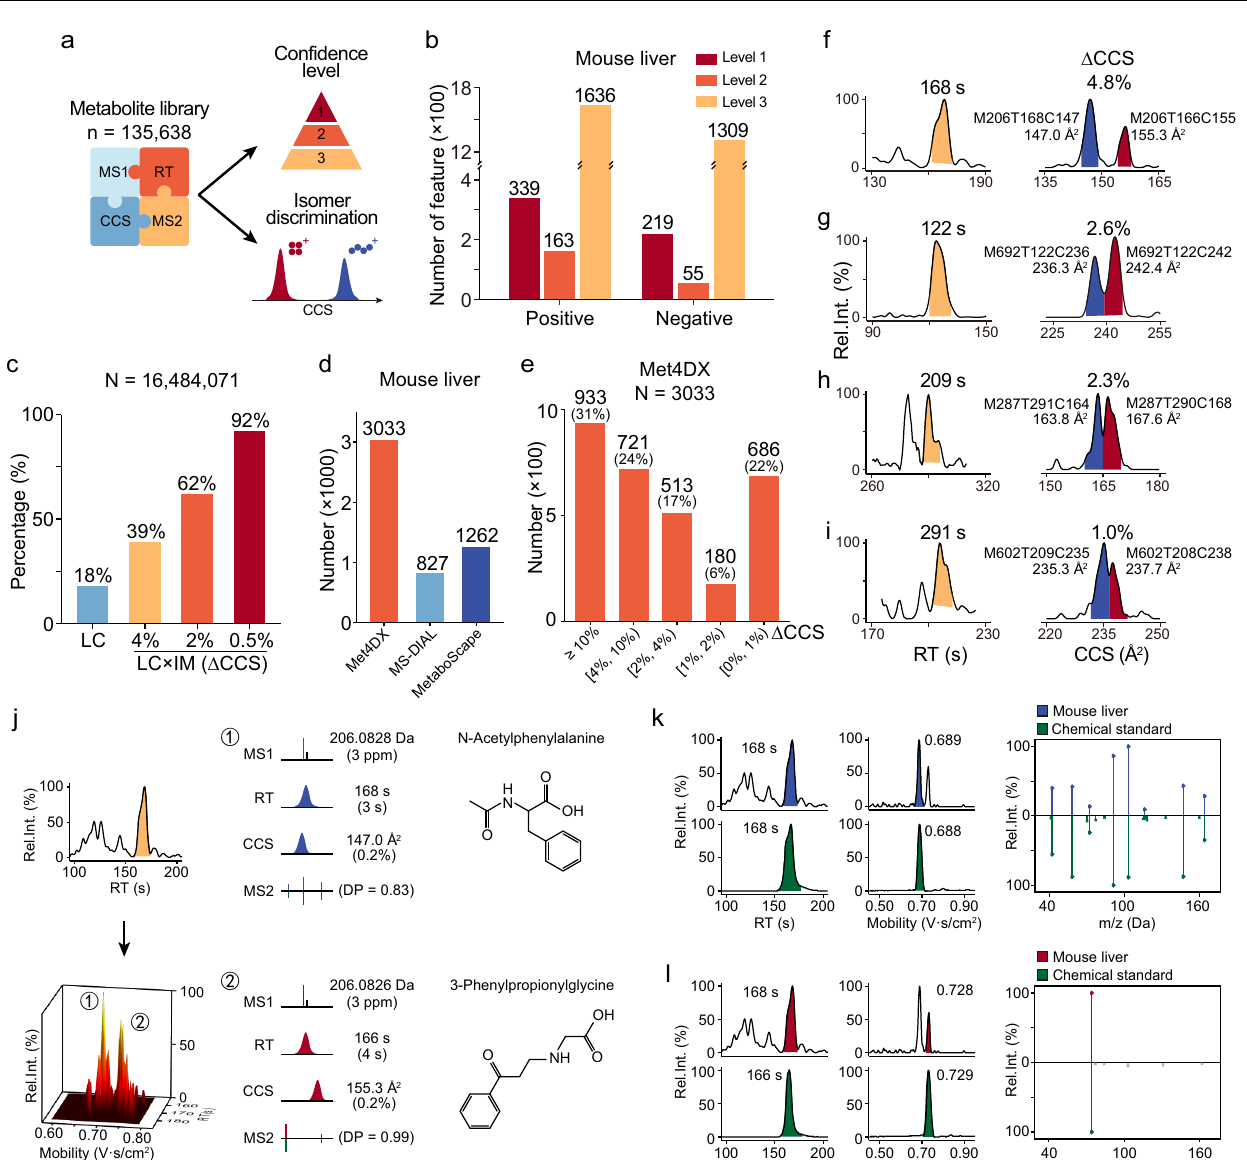
Fig. 5 | Ion mobility-enhanced multidimensional metabolite annotation and isomer differentiation. a The curation of 4D metabolite library in Met4DX